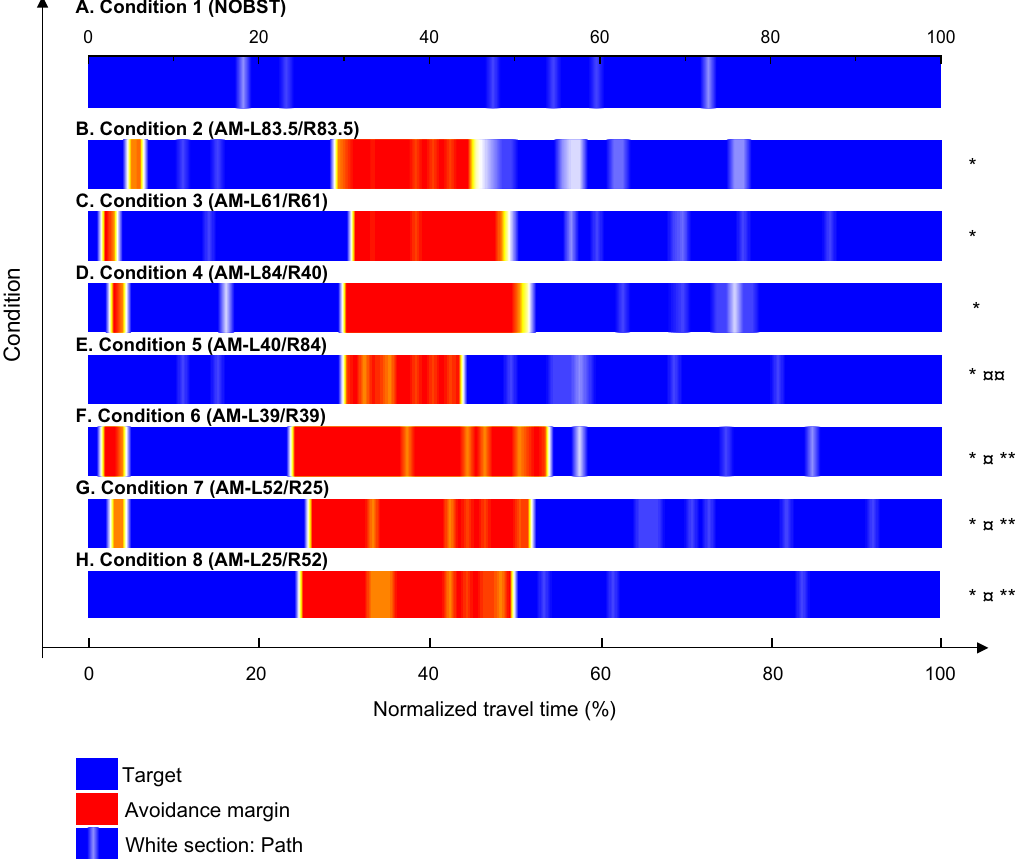
Figure 7. Characteristic gaze object sequences were produced using dynamic time warping barycenter averaging over gaze data from participants for each of the 8 obstacle conditions ( A – H ). The colors in the figure correspond to red as avoidance margin area, white as path area, and blue as target area. The lengths of the sequences were normalized to 100 segments for visualization. * p < .05 as opposed to Condition 1, ¤ p < .05 as oppose to Condition 2, ** p < .05 as oppose to Condition 3, ¤¤ p < .05 as oppose to Condition 4, and ¥ p < .05 as oppose to Condition 5.